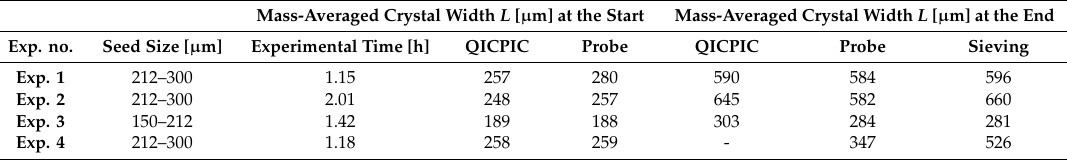
Table 3. Mass-averaged crystal widths evaluated with the optical measurement techniques at the start and the end on Exp. 1–4 KH 2 PO 4